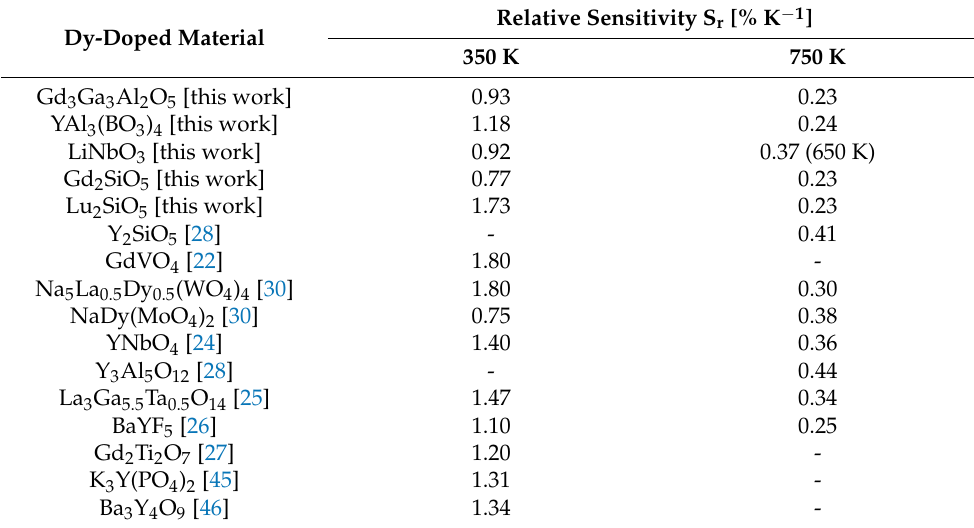
Table 3. Comparison of relative sensitivity S r determined for Dy-doped crystals.